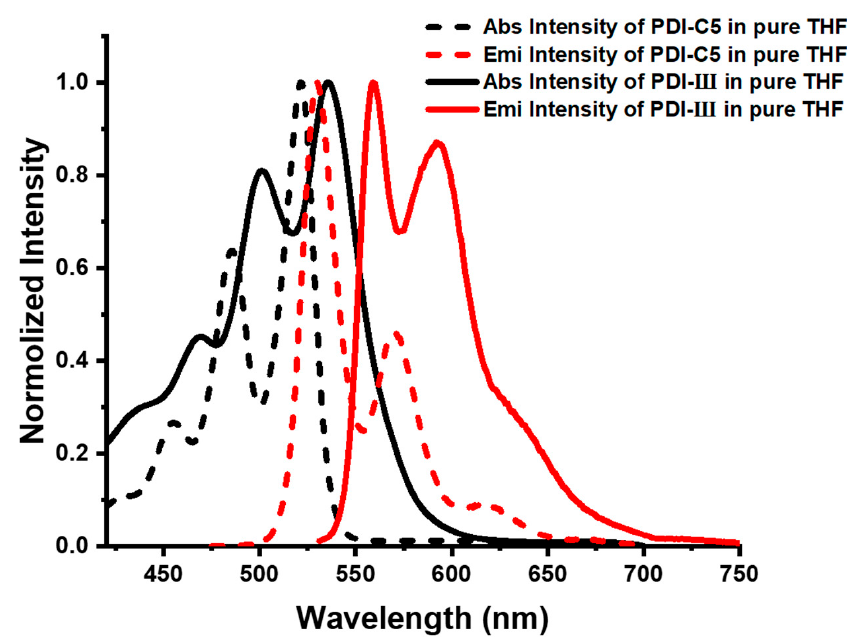
Figure 2. Normalized absorption and fluorescence spectra of PDI-III and PDI-C5 in pure THF.